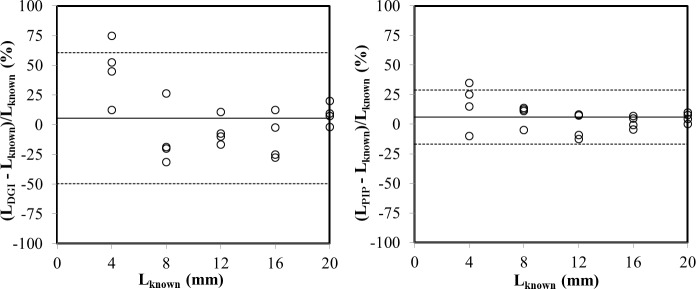
The distribution of the 95% confidence limits (dashed lines) of the mean lengths (solid lines) of possum fur measured by both the DGI (LDGI) and PIP (LPIP) methods and the known lengths of possum fur (Lknown).